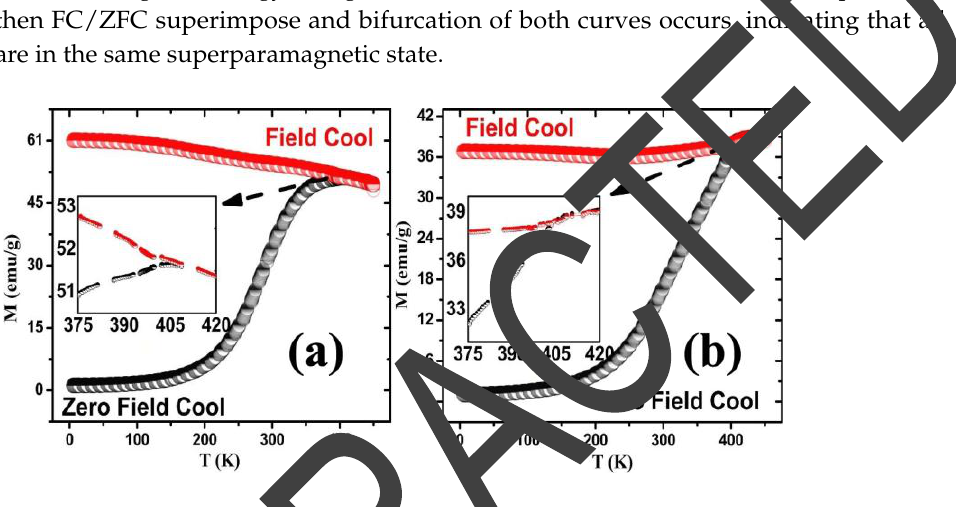
Figure 4. Temperature dependence of the field cooled (FC) and zero field cooled (ZFC) magnetizations for ( a ) core and ( b ) core/shell ferrite nanoparticles.